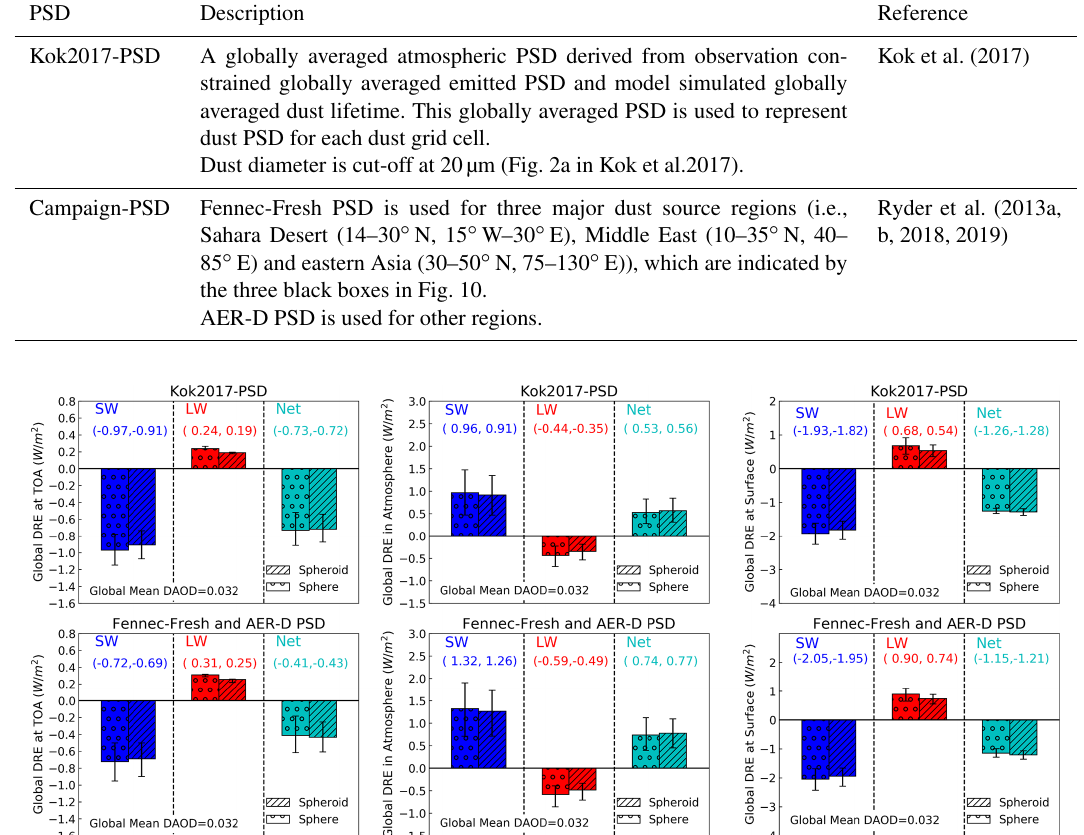
Figure 11. Global annual mean clear-sky DRE SW , DRE LW and DRE NET at TOA, in the atmosphere and surface calculated based on the two PSDs described in Table 5. The two rows represent dust DRE based on two PSDs. Error bars indicate uncertainty induced by dust RI uncertainty. Different types of bars indicate dust DRE based on different dust shapes. This figure explicitly separates the impacts of different dust microphysical properties on dust DRE. The two values in parenthesis on each plot represent spherical (left) and spheroidal (right) dust DRE corresponding to mean